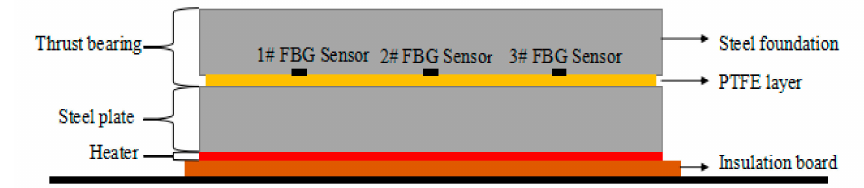
Figure 9. Experimental heating schematic diagram of thrust sliding bearing bush temperature distribution measurement.